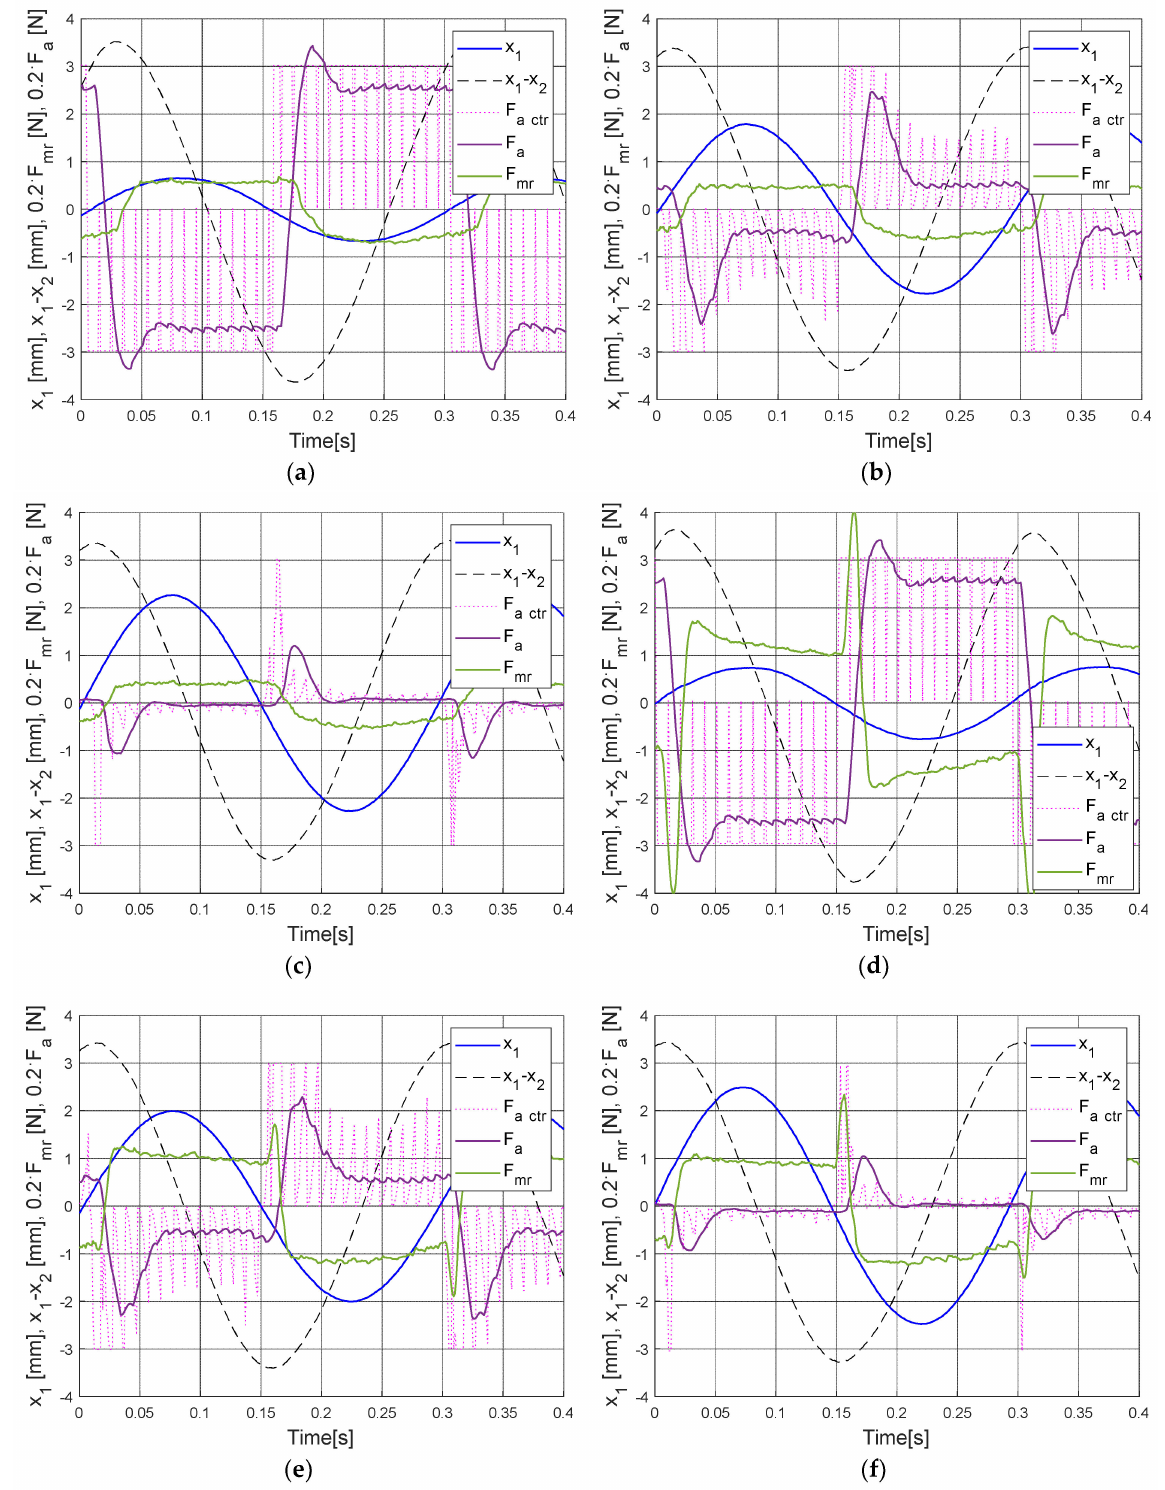
Figure 21. OPT time responses at 3.4 Hz: ( a ) i max = 0 ( b ) i max = 0, g 23 = 10 10 ( c ) i max = 0, g 23 = 10 11 ( d ) i max = 1.0 A ( e ) i max = 1.0 A, g 23 = 10 10 , ( f ) i max = 1.0 A, g 23 = 10 11 ( F nom = 12.5